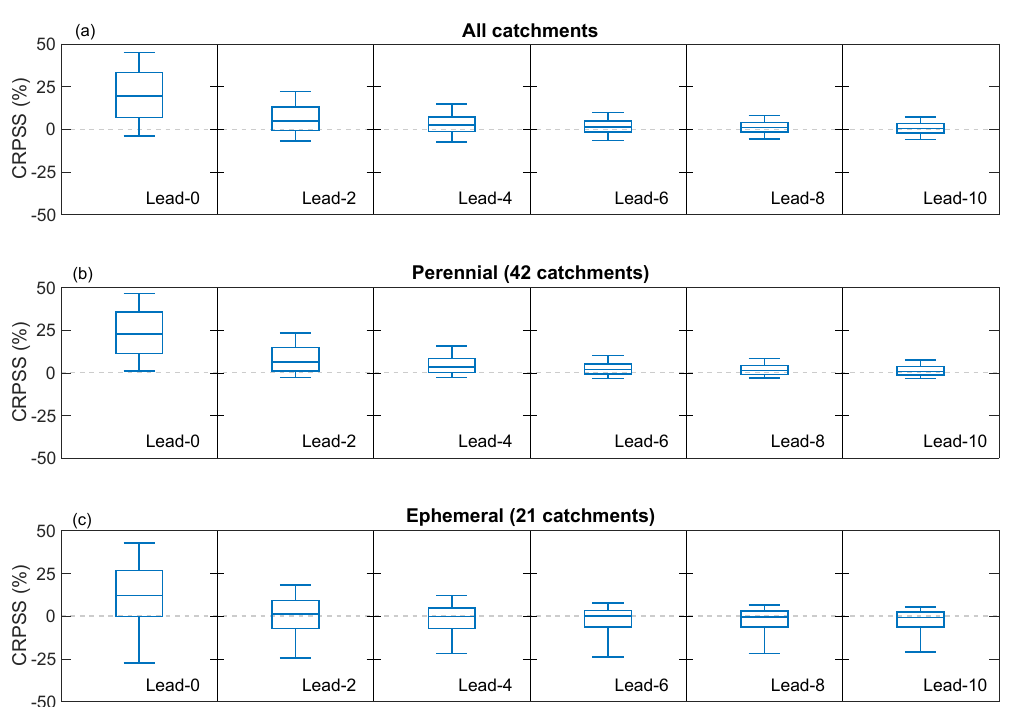
Figure 3. Forecast skill (CRPSS) for 63 catchments by lead time for the FoGSS base case. For each lead time, forecast skill is summarized for all months and catchments with box and whisker plots. Boxes show the interquartile range with the median; whiskers give the 10th and 90th percentiles. (a) shows all catchments, (b) shows perennial catchments, and (c) shows ephemeral